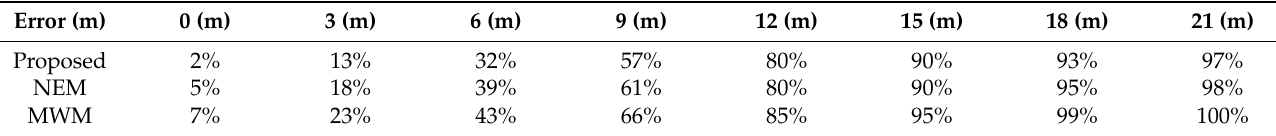
Table 14. KNN with MWM Simulated Test Samples.